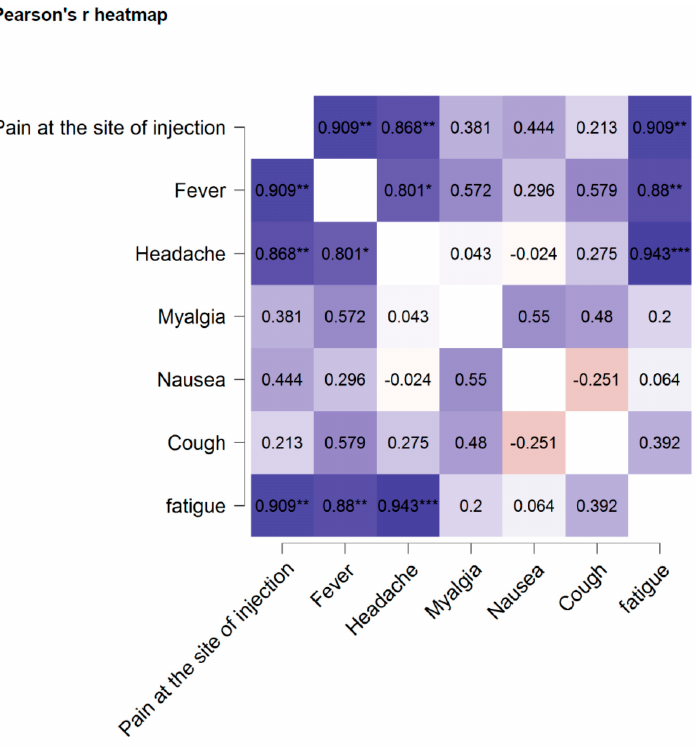
Figure 8. ‘Pearson’s heatmap. Pearson’s heatmap illustrates the correlation among different side effects of COVID-19 vac- cines that have been used in the Kingdom of Bahrain. * p < 0.05, ** p < 0.01, *** p <